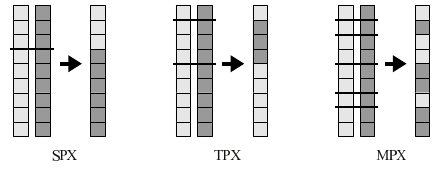
Figure 3. Sketch of crossover